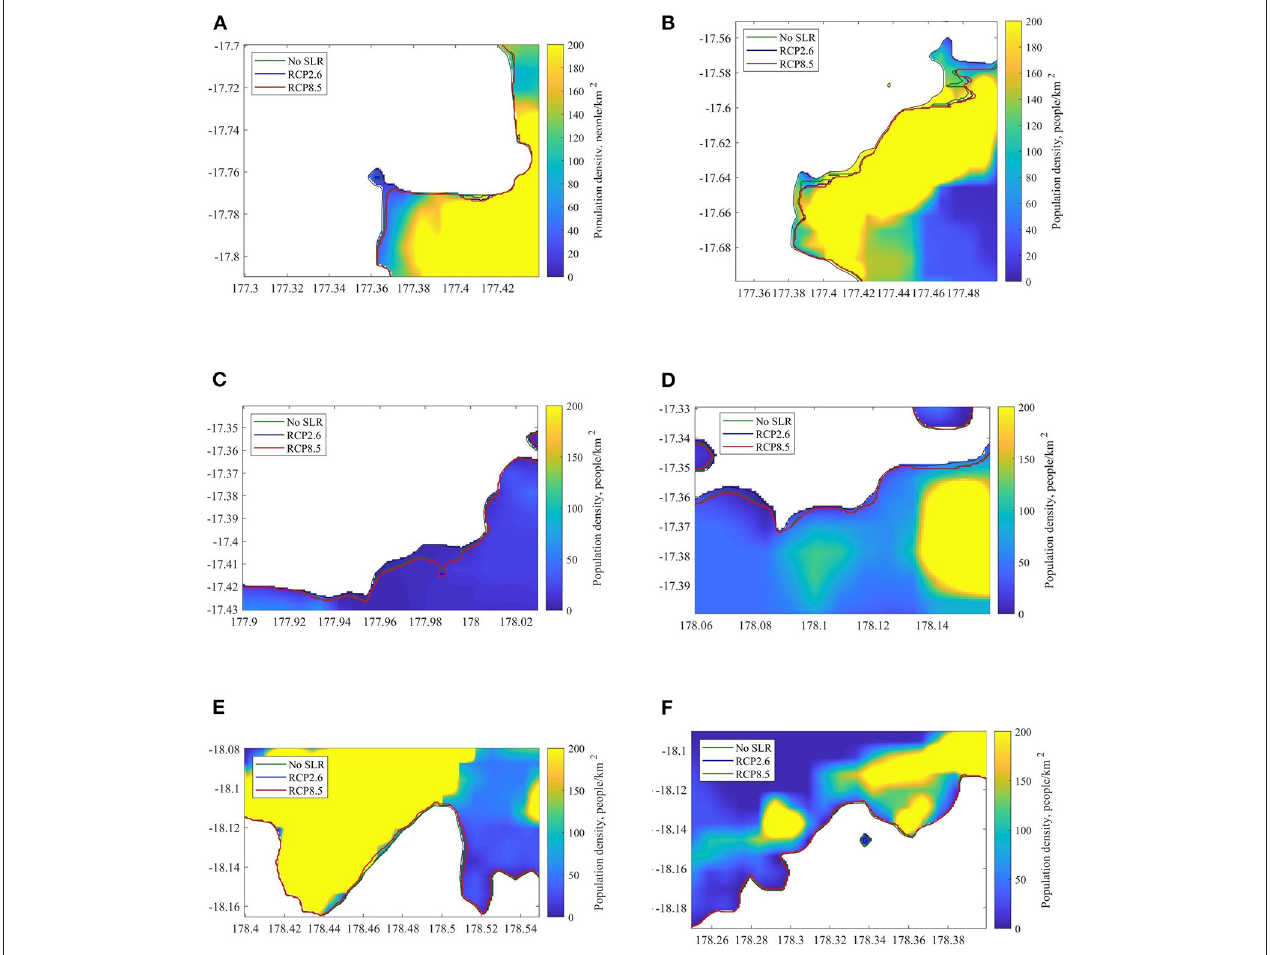
FIGURE 12 | Relationship between the population density and inundation area in the selected 6 locations. The area of the 6 locations are shown in Figure 3B (unit: a number of people/km 2 ). (A) Location #1, (B) Location #2, (C) Location #3, (D) Location #4, (E) Location #5, and (F) Location #6.